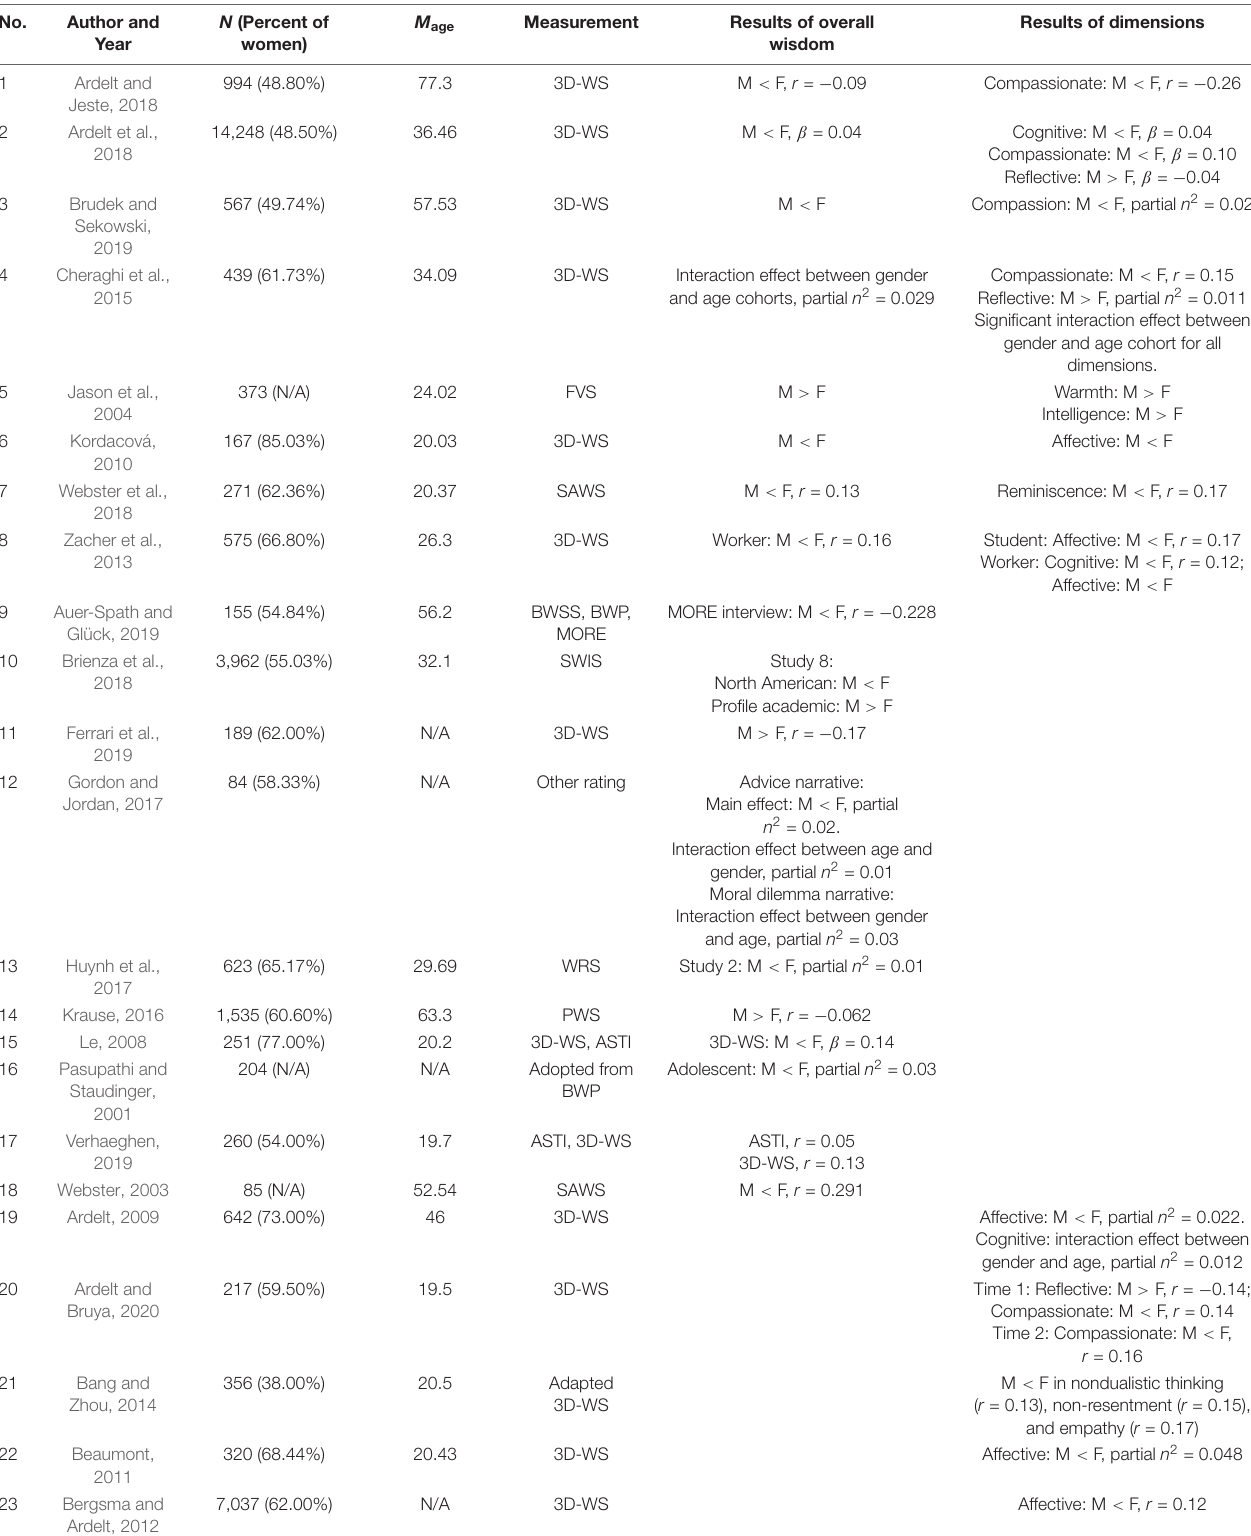
TABLE 2 | Significant gender effect on wisdom